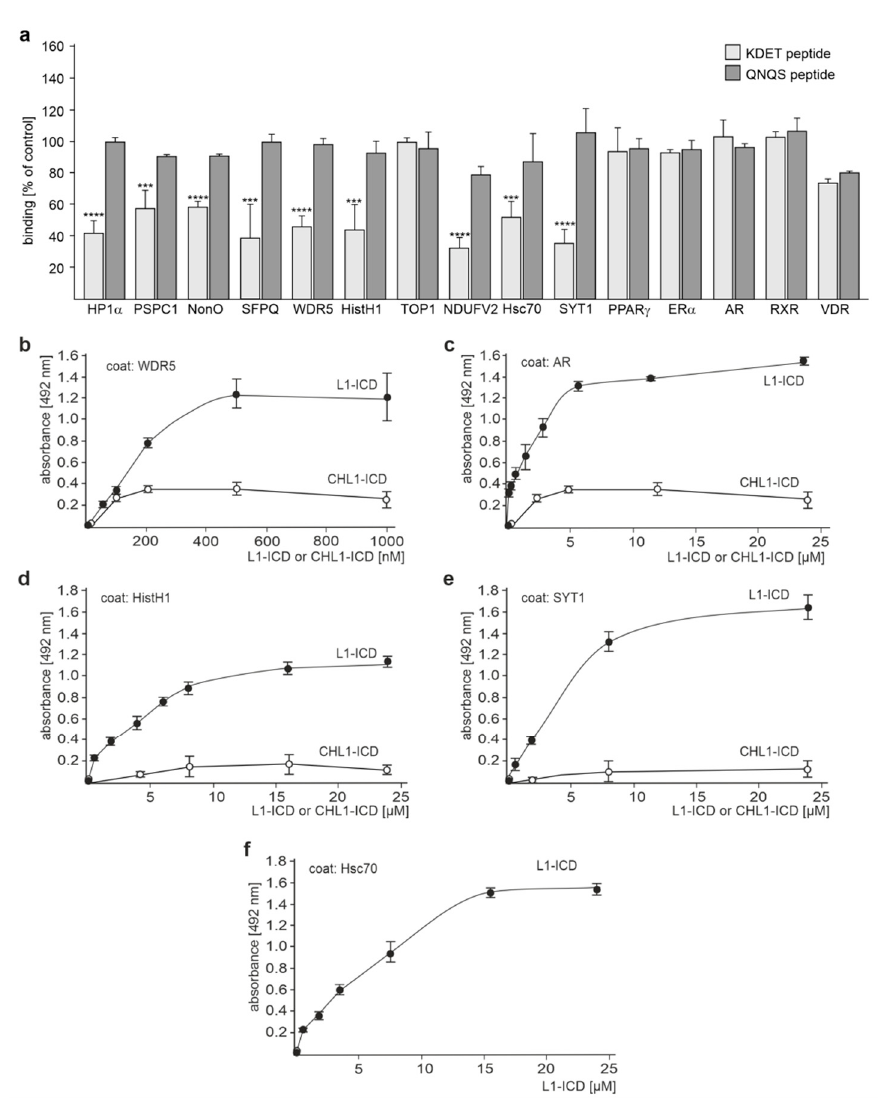
Figure 2. L1-ICD binds to several binding partners via its KDET motif. Recombinant L1-binding partners were substrate-coated and incubated with a constant L1-ICD concentration in the absence or presence of the KDET peptide or QNQS control peptide ( a ) or with increasing L1-ICD concentrations ( b – f ). Binding was determined by ELISA using mouse L1 antibody C-2 and horseradish peroxidase- conjugated secondary antibodies. The mean values ± SD from three independent experiments carried out in triplicate are shown for the binding relative to control (values in the absence of peptides set to 100%). *** p < 0.005, **** p < 0.001; one-way ANOVA with Bonferroni ´ s multiple comparison